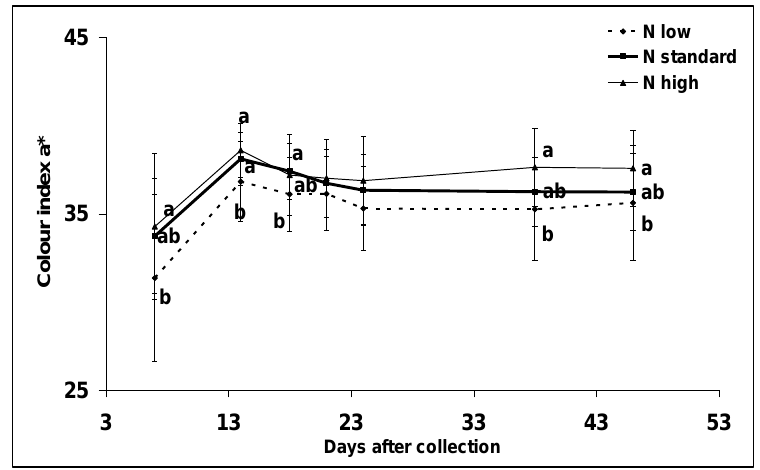
Figure 2. Nitrogen input effect on colour index a* during postharvest storage from the pink stage to complete ripeness. Means with different letters are significantly different ( p < 0.05). Error bars indicate standard deviations.